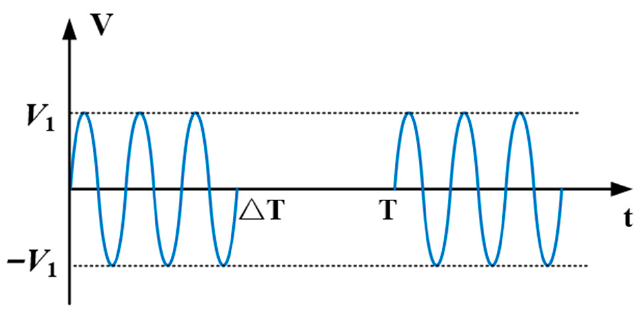
Figure 2. Waveform of PW in the time domain.